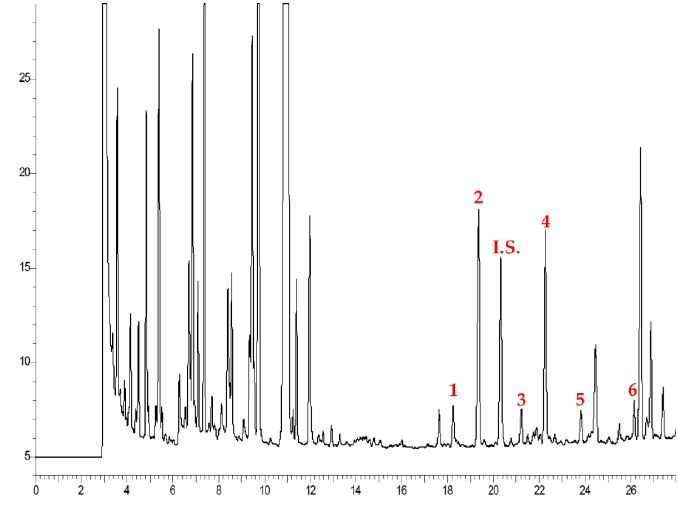
Figure 3. GC–FID chromatogram of COPs in biscuits .